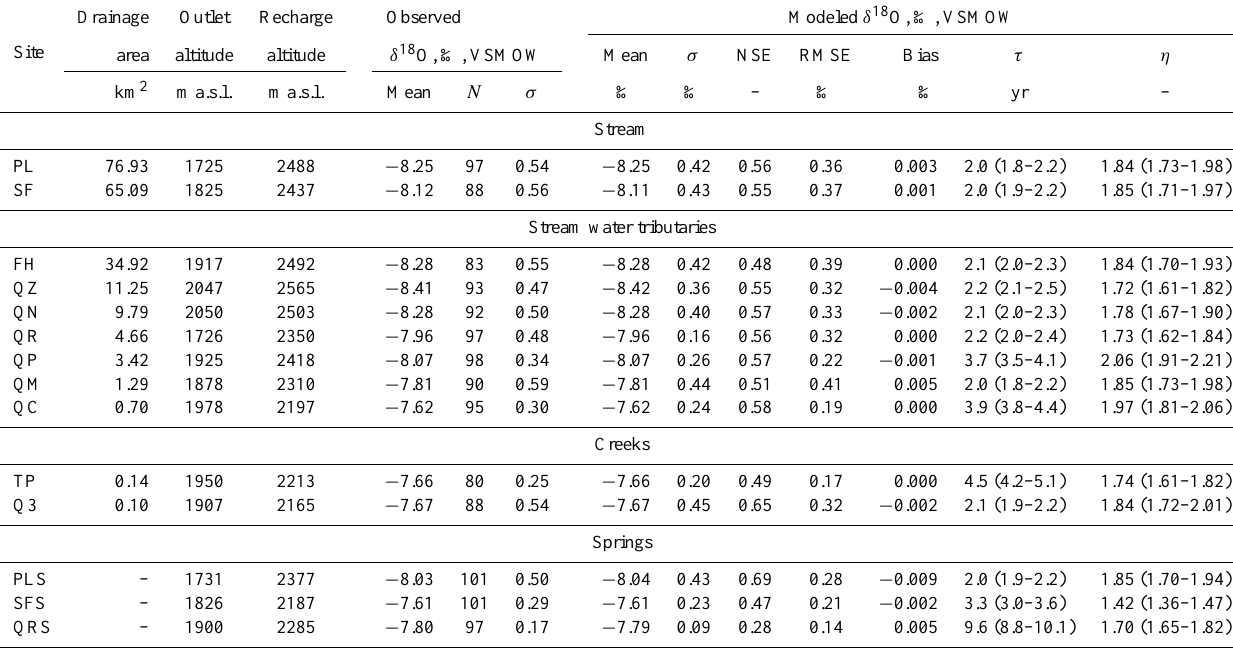
Table 5. Main statistical parameters of observed δ 18 O and predicted results for surface and spring waters using an EPM distribution function. Statistical parameters of modeled results: RMSE, bias, mean and σ correspond to the best-matching value of the objective function NSE. Uncertainty bounds of modeled parameters ( τ and η ), calculated through generalized likelihood uncertainty estimation (GLUE), are shown in parenthesis.